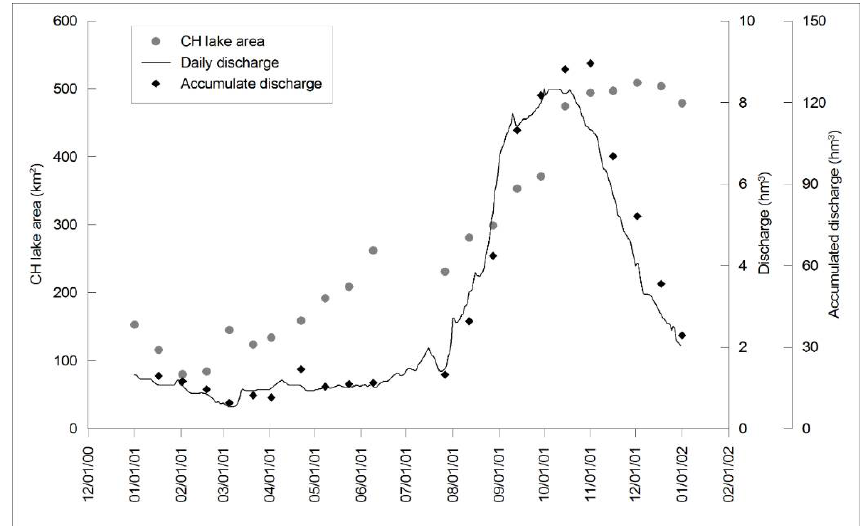
Figure 5. Comparison of the CH lake area calculated with MOD13Q1v6 middle infrared electromagnetic range (MIR) band and Falso Senguer river daily discharge from January 2001 to January 2002. From January to July 2001 the lake area and river daily discharge remained lower than their mean value for this period (279 km 2 ; 2.7 hm 3 ). Both lake area and river discharge stayed higher than their mean from August to mid-December 2001.